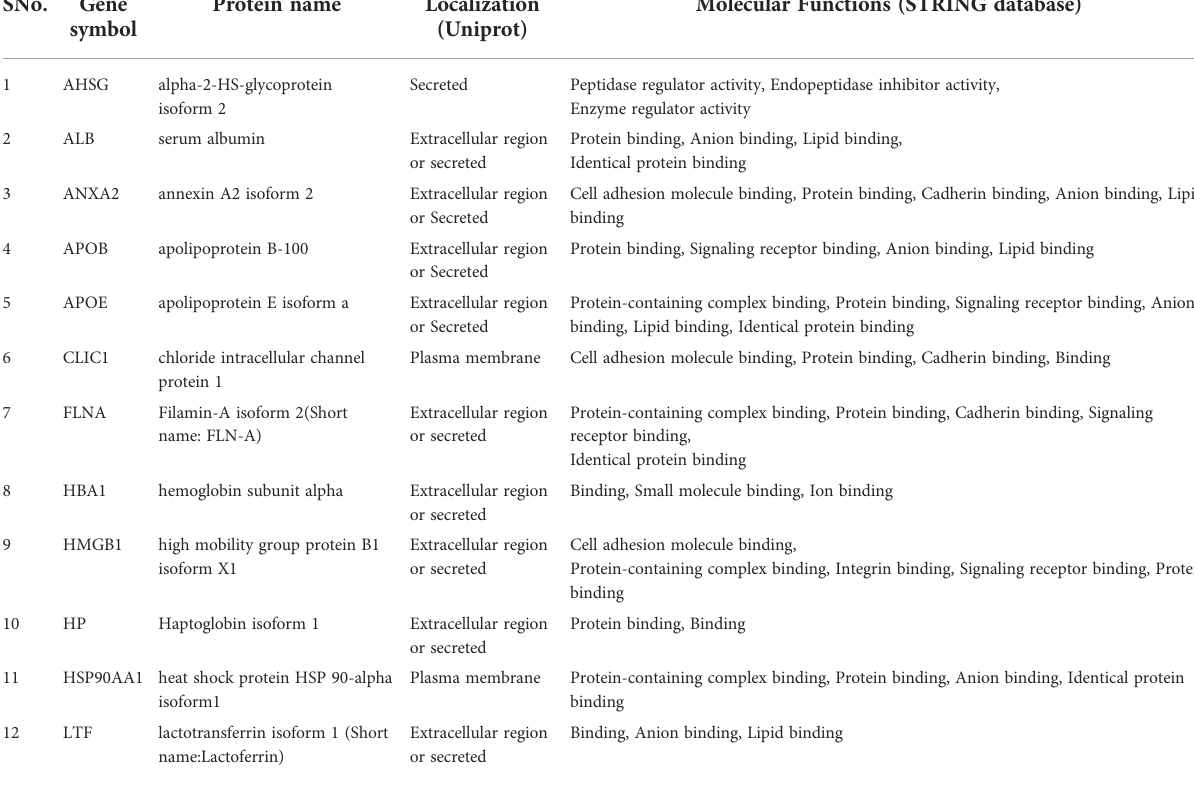
TABLE 2 List of 16 proteins reported to be differentially abundant in GBC tissue as well as in plasma and plasma-derived EVs.